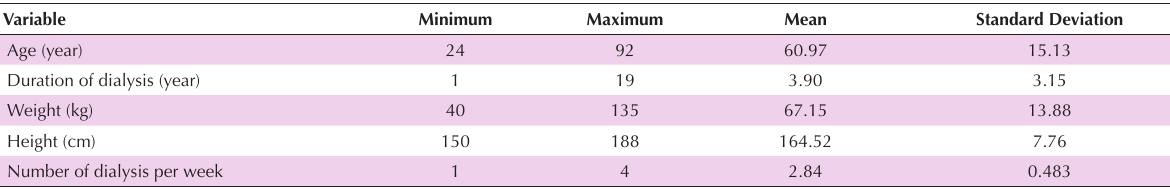
Table 1. Clinical characteristics of the patients undergoing hemodialysis Variable Minimum